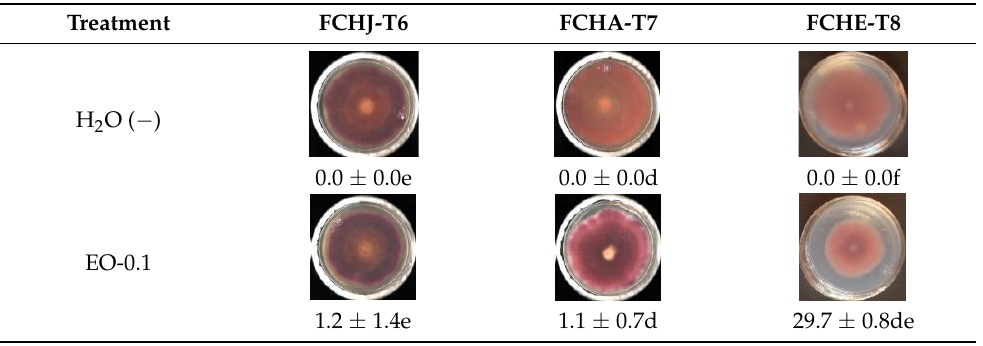
The values are presented in percentage of inhibition of radial growth. FCHA-T7 and FCHJ-T6: 120 h (five days); FCHA-T8: 144 h (six days). Values are the average of three repetitions ± standard error. Values with different letters in the same column are different ( p ≤ 0.05). H 2 O (−): negative control (sterile distilled water); EOFS: essential oil from the P. au- ritum aerial part; SPK (+): positive control (prochloraz, Sportak ® ); and PIRG: percentage of inhibition of radial growth. Table 5. Inhibition of radial growth of Fusarium spp. by aerial part essential oil of P. auritum at different concentrations (mg/mL).